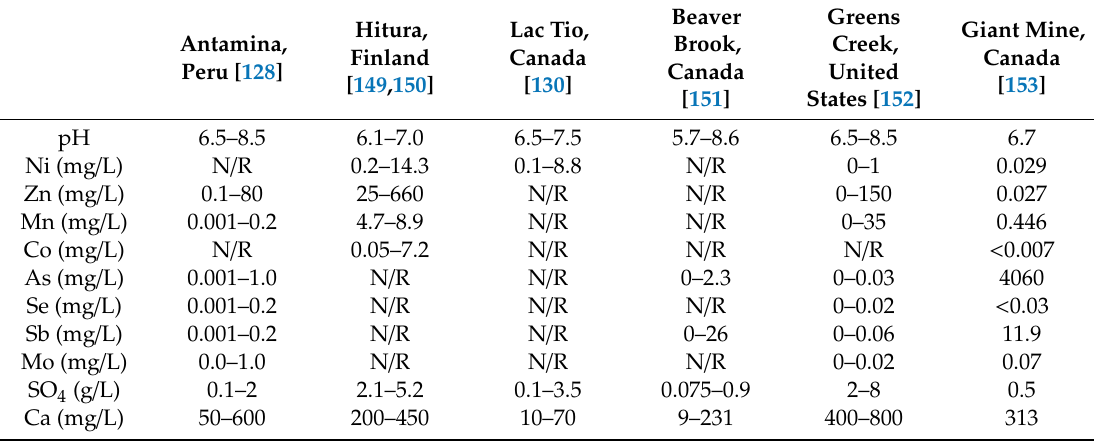
Table 2. Examples of neutral rock drainage (NRD) chemistries reported at di ff erent mine sites around the